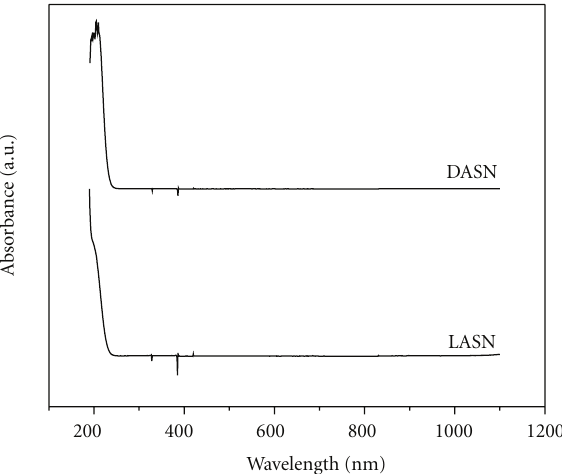
Figure 5: UV-Vis window of the LASN and DASN.